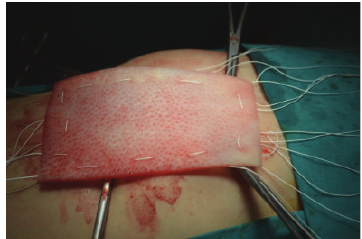
Figure 3: The collagen matrix was positioned in an underlay technique and was secured in the rectus muscles with at least 3 cm overlap beyond the fascial margins using interrupted Gore-Tex 2.0 sutures every 2cm.